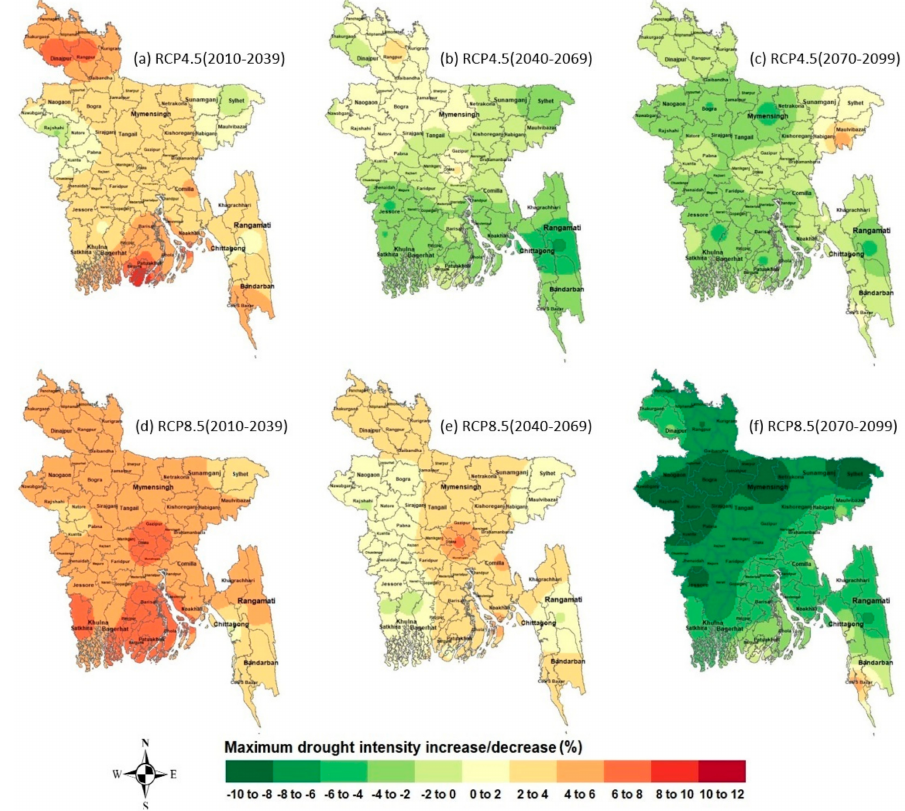
Figure 11. Percentage (%) change in the maximum drought intensity over Bangladesh for the 2010s (1st column), 2040s (2nd column), and 2070s (3rd column) under the RCP4.5 (upper row) and RCP8.5 (lower row) scenarios relative to the baseline period